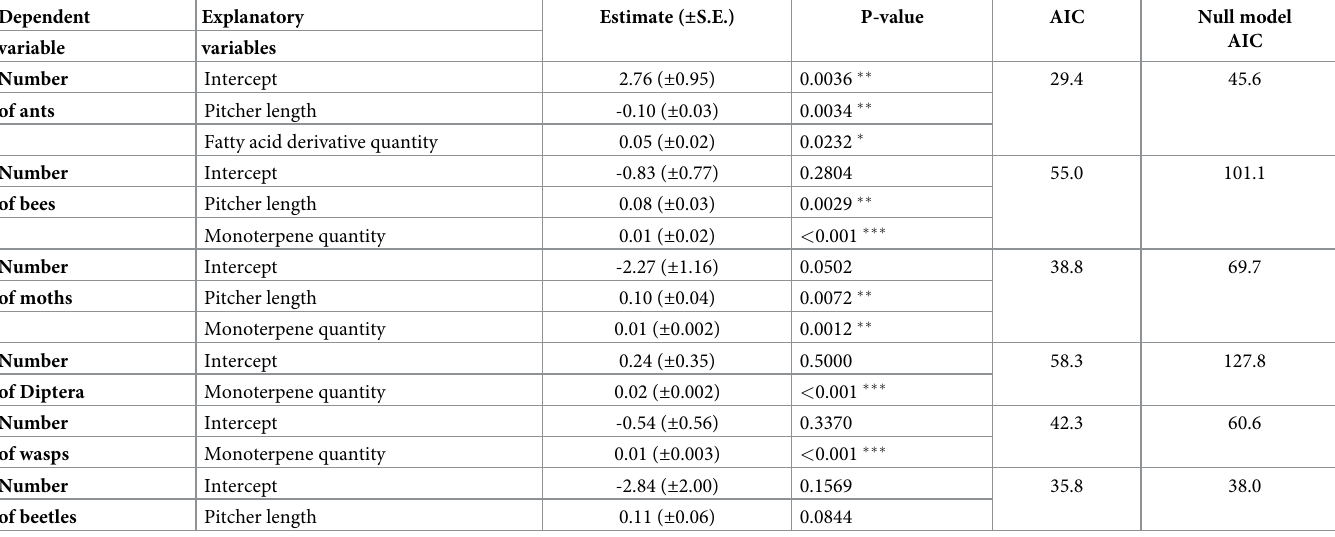
Table 4. Effect of pitcher traits on captures of different groups of prey in S . X leucophylla